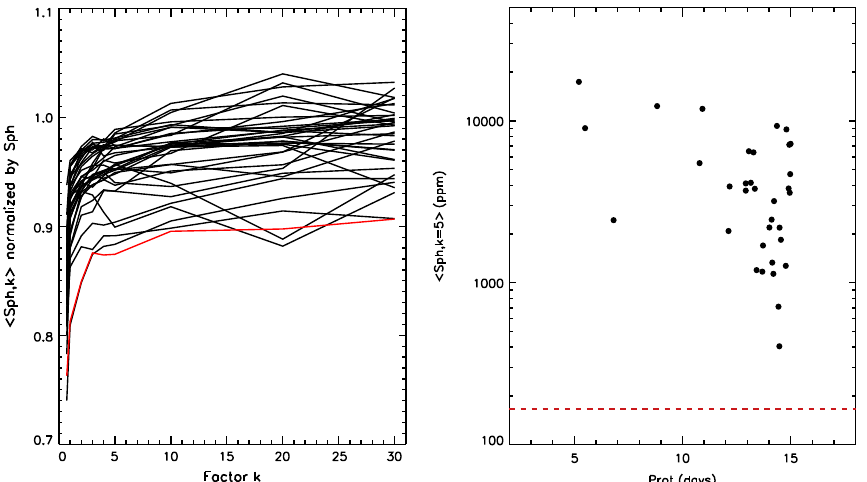
Fig. 3. Left : Normalised mean standard deviation as a function of k , which is the multiplicative factor of P rot to determine the size of the subseries, for the 34 M dwarfs of our sample (black curves) and the Sun (red curve). Right : Magnetic activity index for the value k = 5, S ph ; 5 (cid:2) (cid:3) , corrected from the photon noise, as a function of the rotation period for the 31 non-polluted M dwarfs. The red dashed line corresponds to the solar value.